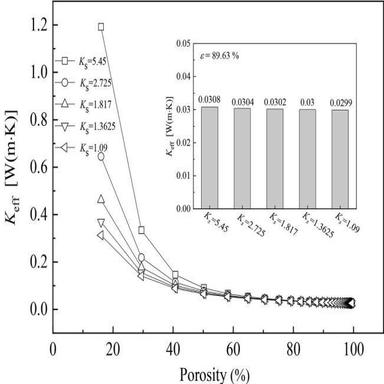
The relationship between thermal conductivity and porosity of MFW_11110 fractal structure under different Ks value.